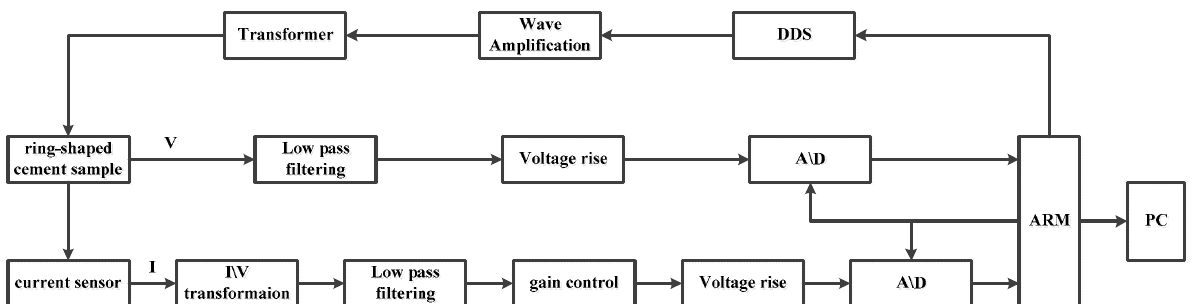
Figure 2. The hardware circuit structure diagram of NCACII.